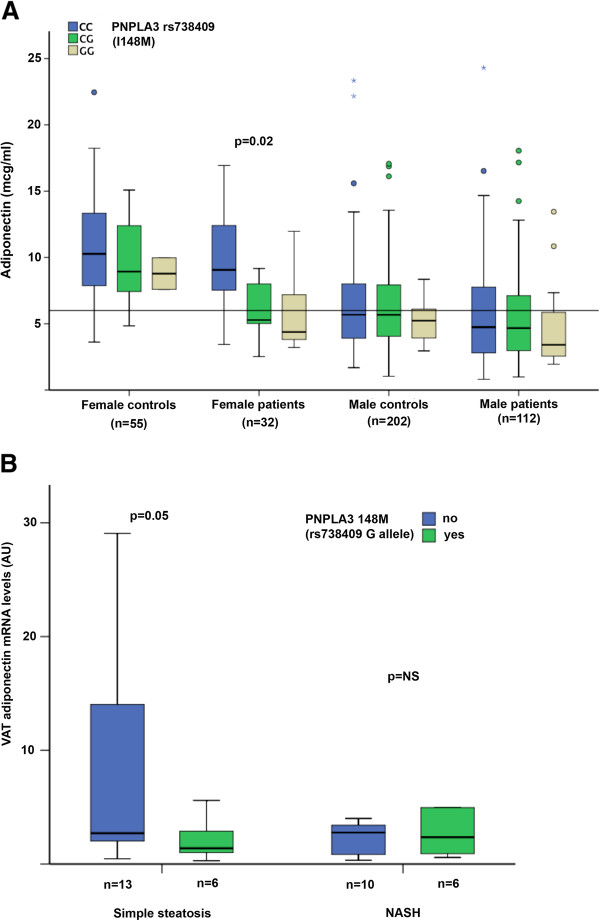
Effect ofPNPLA3genotype on serum adiponectin.A) Adiponectin levels according to I148M PNPLA3 genotype in subjects stratified according to gender and NAFLD diagnosis vs. healthy controls. B) Adiponectin mRNA levels (AU: arbitrary units) in VAT of morbidly obese patients according to the presence of NASH and I148M PNPLA3 genotype.